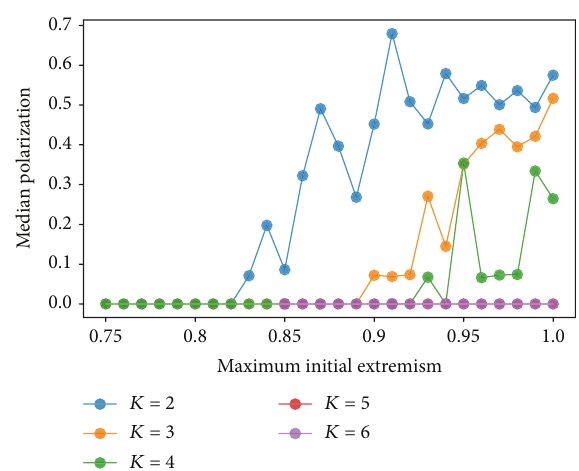
Figure 8: Median fi nal polarization for di ff erent cultural complexities over maximum initial opinion magnitude, S . Median polarizations for K = 5 and K = 6 are both fl at at zero; K = 5 data is obscured by K = 6